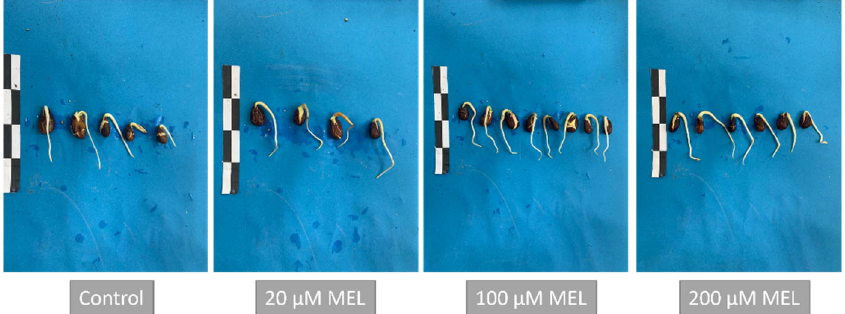
Figure 2. Representative photo of germinated almond seeds primed with different concentrations of melatonin (MEL) and incubated in chamber A after 30 days. Scale: each black or white mark represents 4 cm × 1 cm.